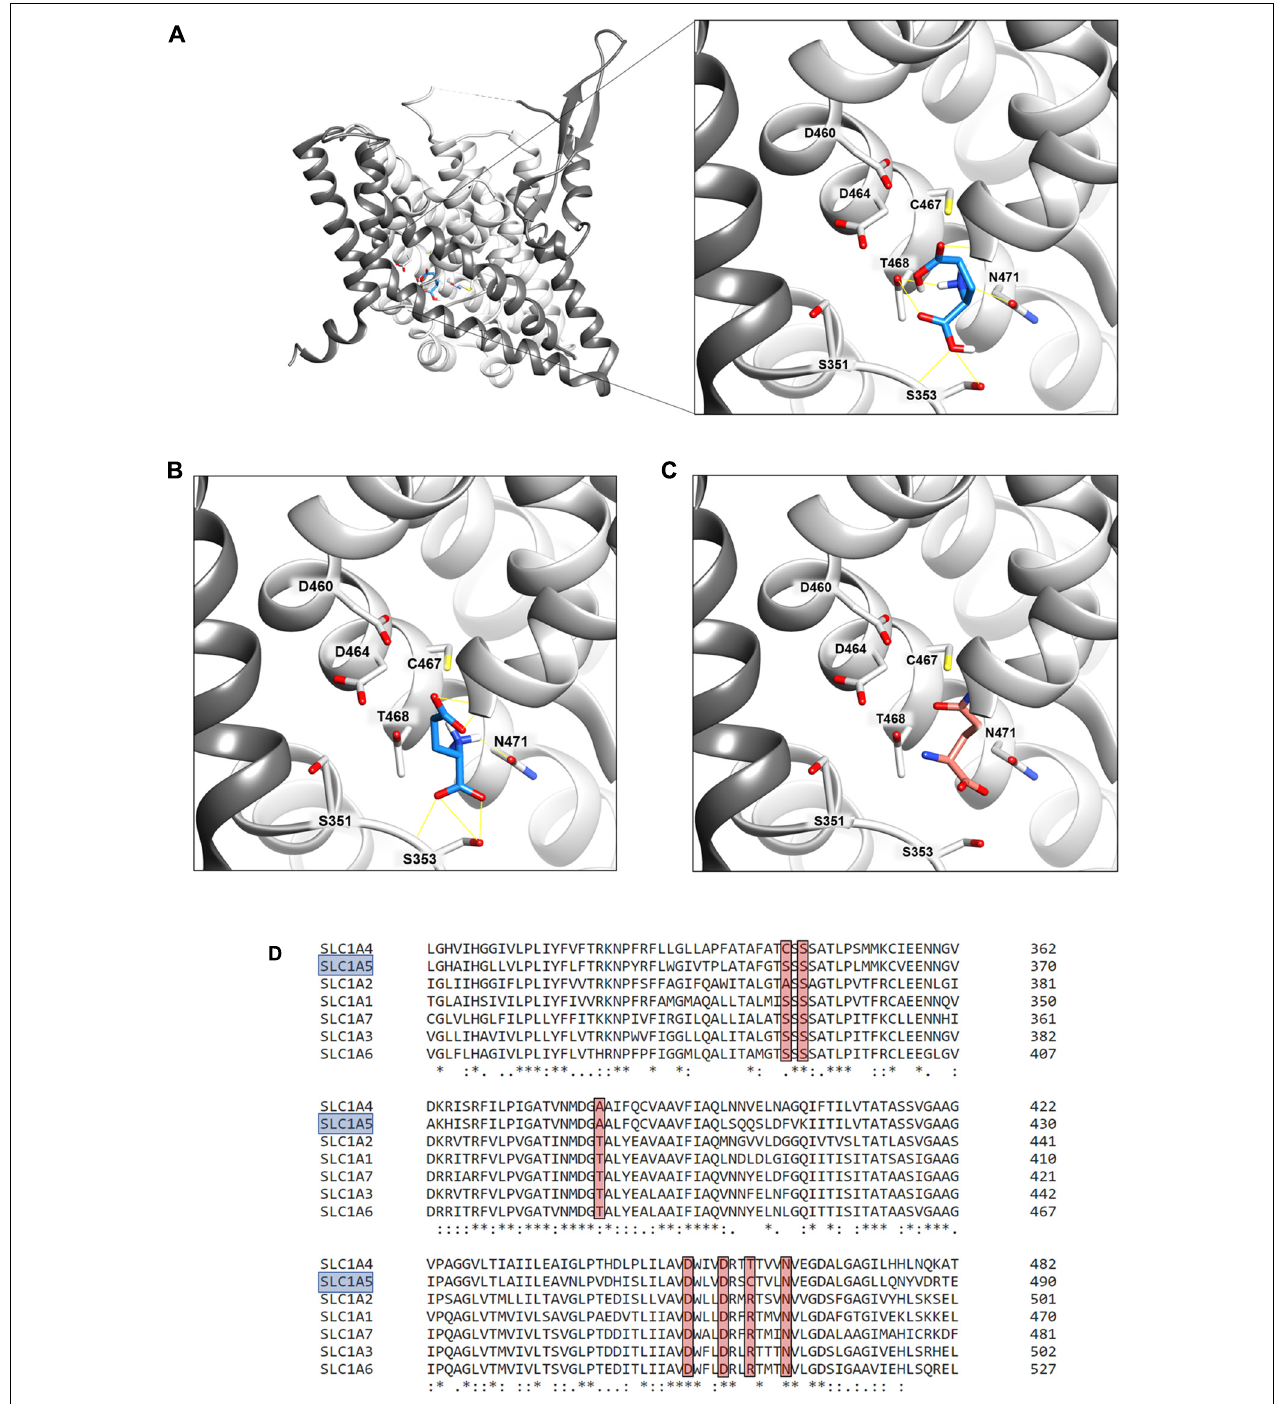
FIGURE 11 | Sequence alignment and docking analysis of the hASCT2 binding site. In (A,B) , Molecular docking of glutamic acid in the binding site of ASCT2. The crystal structure of ASCT2 in the inward open conformation has been used (PDB ID: 6GCT). To simplify the visualization, only the Chain A without Cholesterol was represented as light gray ribbon, with the scaffold domain in dim gray, using Chimera v.1.14. In (A) , a zoom of protonated glutamate docking in the binding site. The ligand was represented as dodger blue stick and amino acids belonging to the binding site as a stick and labeled using Chimera v.1.14. Glutamate in the protonated state was prepared at a pH range of 2.0 ± 0.5 using Schrödinger-Maestro v.12.4 and docking was performed using AutoDock Vina v.1.1.2 as described in materials and methods. This pose has a docking score of − 6.0 and it makes hydrogen bonds with G435, T468, N471, and S353. In (B) , a zoom of deprotonated glutamate docking in the binding site. The ligand was represented as dodger blue sticks and amino acids belonging to the binding site are represented as a stick and